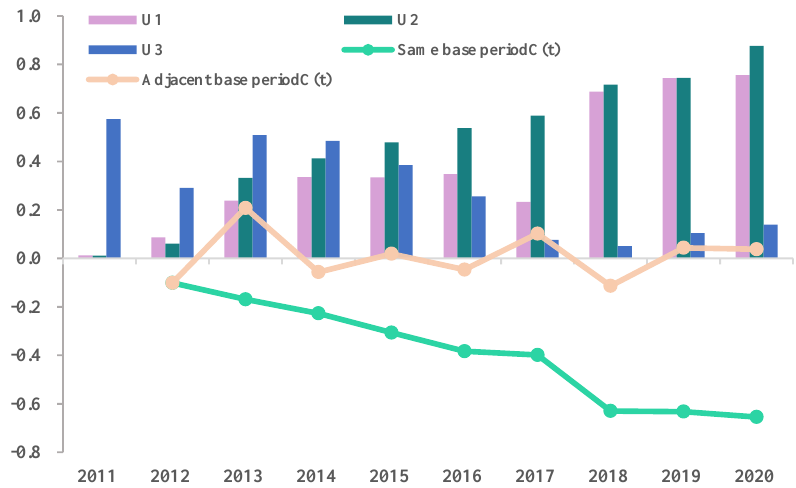
Figure 5. Orderliness of logistics industry ESE-B subsystems and synergy of composite systems.